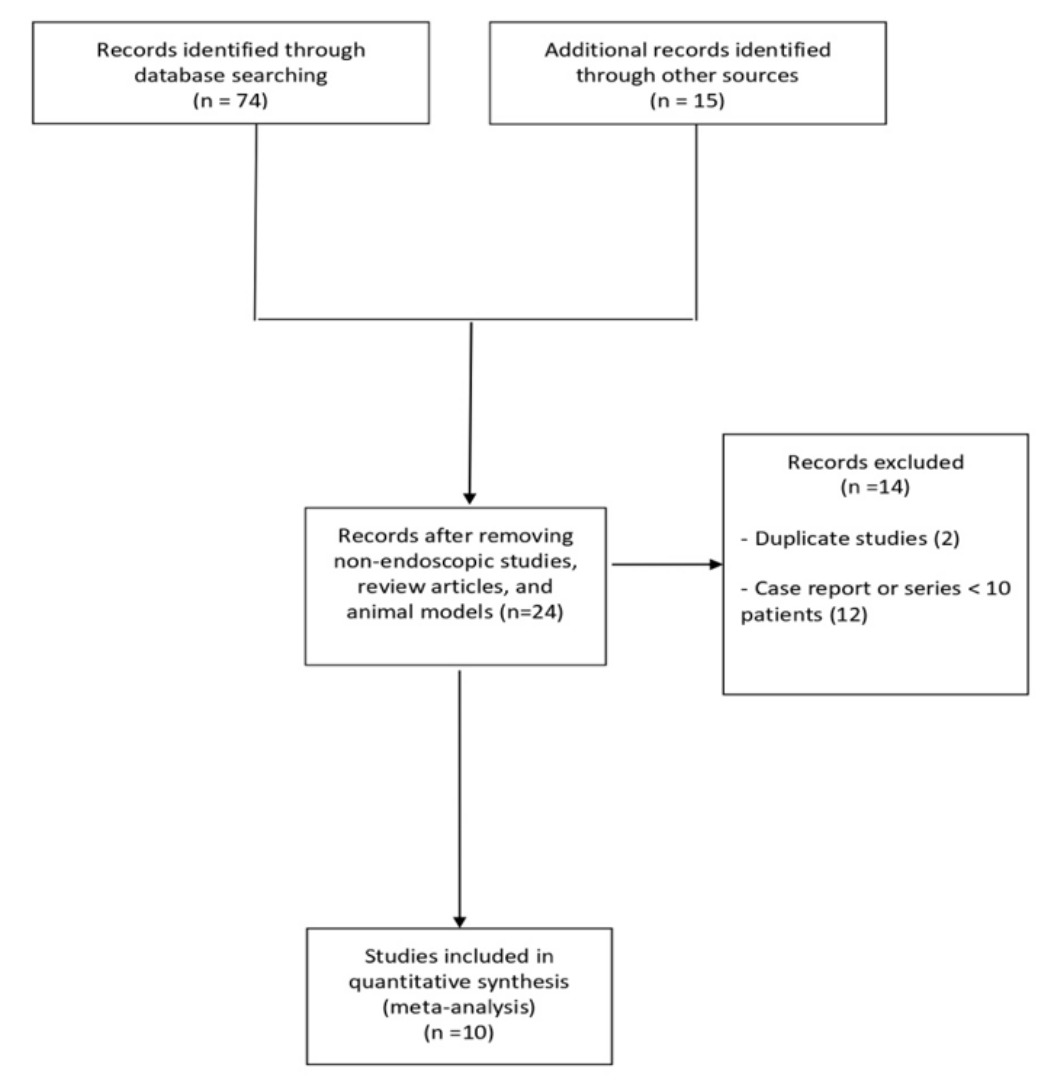
Figure 1. Flow chart of the included studies . Table 1. Characteristics of included studies.